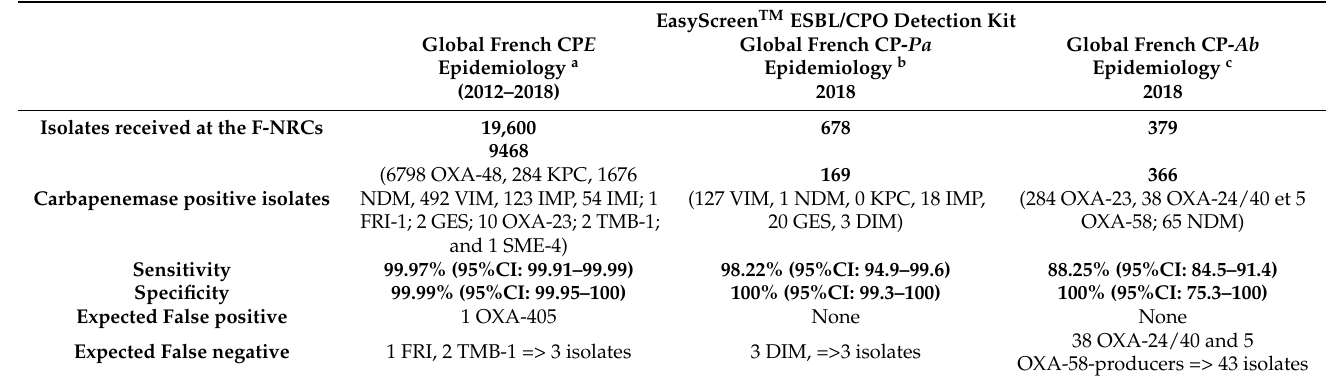
Table 5. Global performances of the EasyScreen TM ESBL/CPO Detection Kit extrapolated to the global French epidemiology of